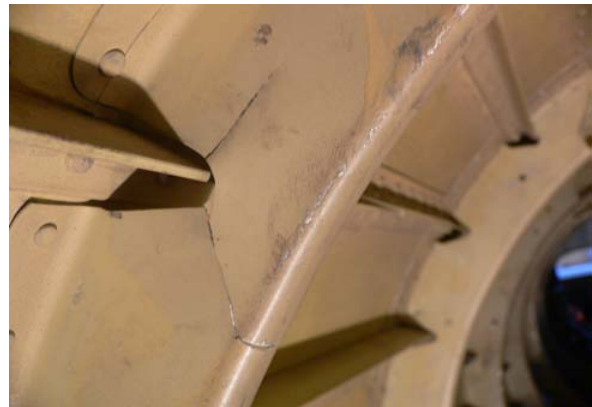
Fig 4. Fatigue cracks in frame as a result of dynamic overload induced by additional concentrated weight